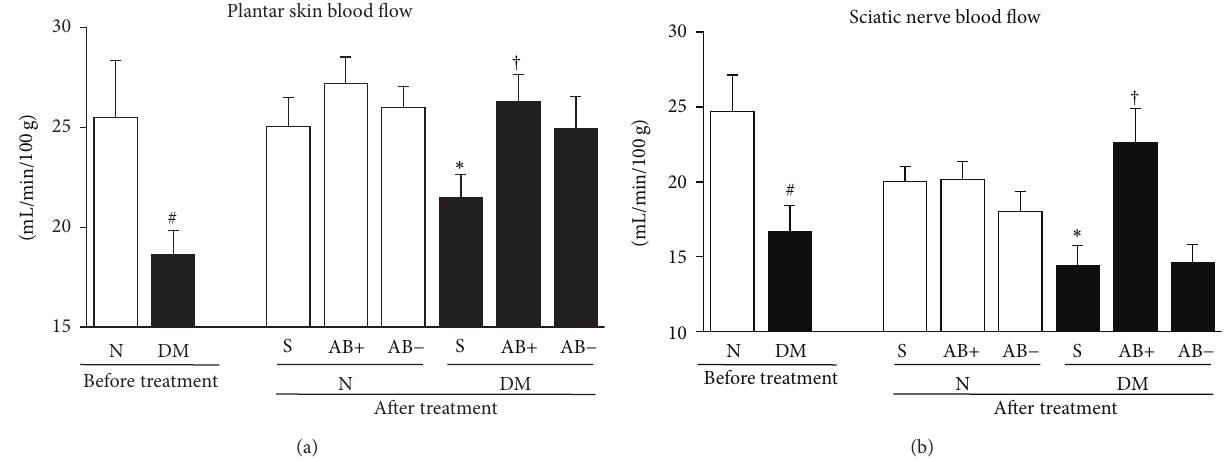
Figure 7: Blood flow of sciatic nerves and plantar skins were ameliorated by transplantation of angioblast-like cell derived from ES cells (ES-ABs). At a time point of 12 weeks of diabetes (before treatment), blood flows of plantar skins (a) and sciatic nerves (b) in diabetic mice significantly decreased compared with those in normal mice, and, 4 weeks after transplantation (after treatment), the decreases were ameliorated in transplanted limbs of diabetic mice. However, administration of ES-ABs did not alter blood flow in those of normal mice. N: normal mice limbs, DM: diabetic mice limbs, S: saline-injected limbs, AB+: limbs transplanted ES-ABs, and AB − : contralateral limbs transplanted ES-ABs. Results are means ± SD. # 𝑃 < 0.05 versus pretreatment N. ∗ 𝑃 < 0.05 versus posttreatment S-treated N, † 𝑃 < 0.05